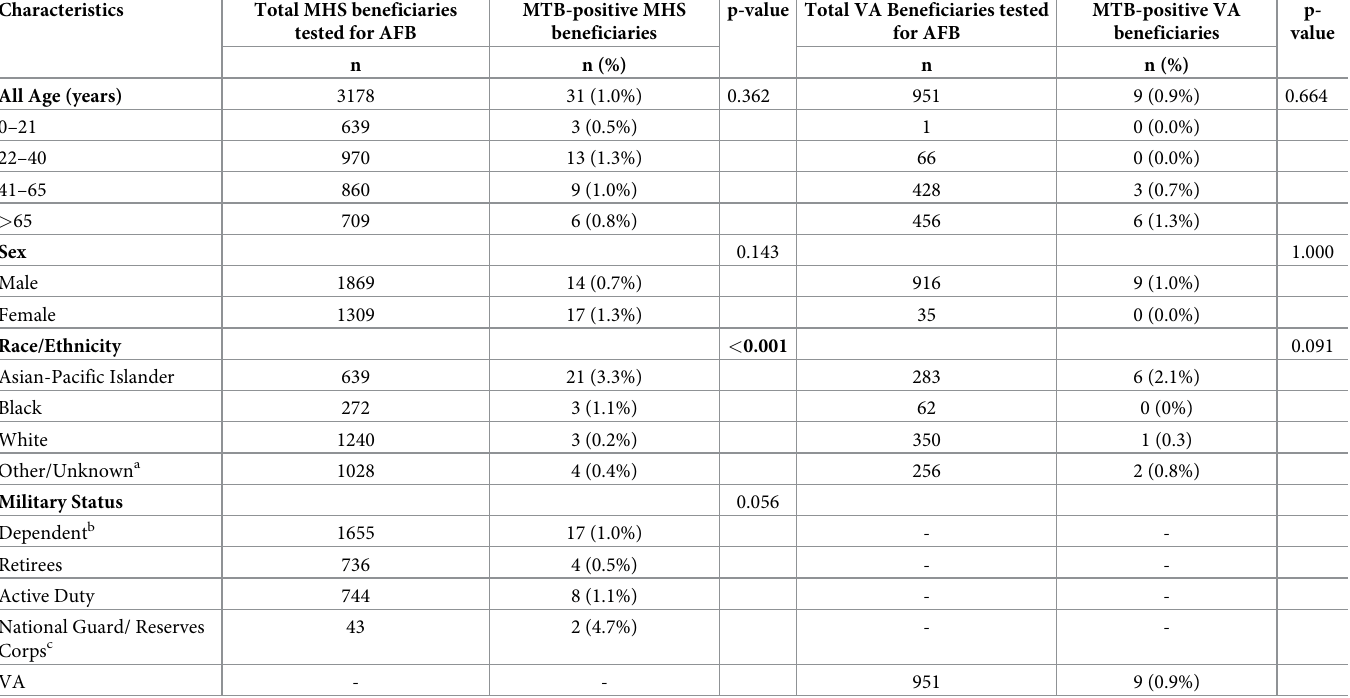
Table 1. Characteristics of Military Health System (MHS) and Veterans Affairs (VA) beneficiaries with acid-fast cultures processed at Tripler Army Medical Cen- ter, from January 2002 to November 2019.